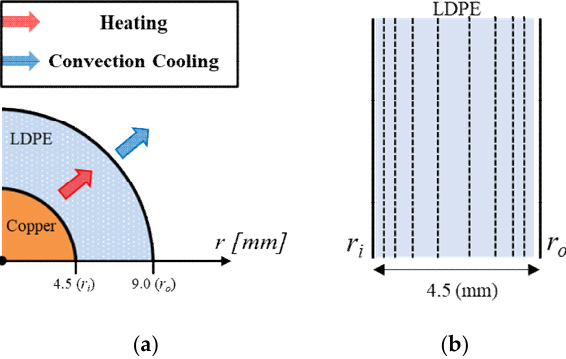
Table 1. Parameters used for the simulations.